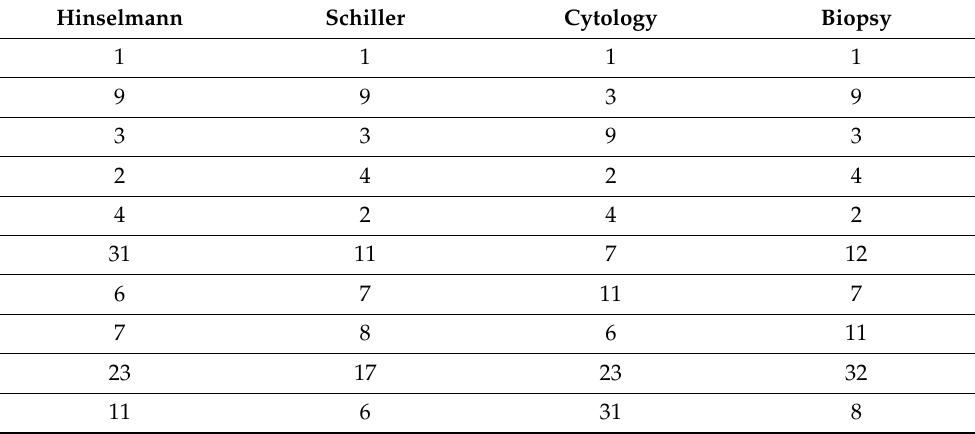
Table 3. Top 10 factors for four target variables based on RF relative importance